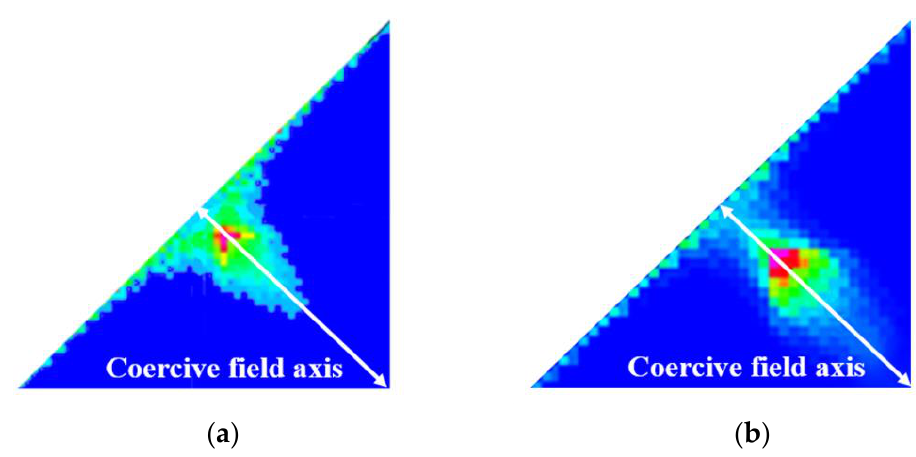
Figure 12. Preisach density distribution according to magnetic materials: ( a ) SS400 and ( b ) SM45C.